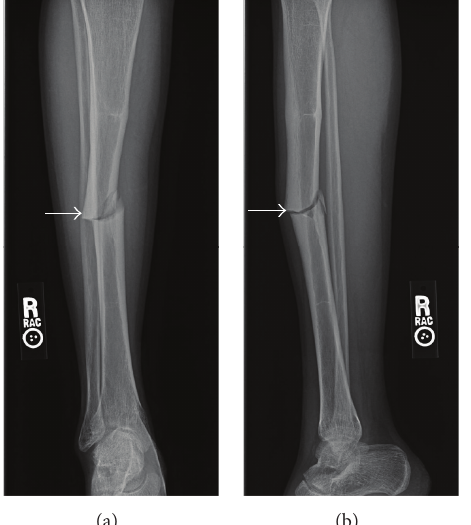
Figure 1: Young adult male with history of Rothmund-Thomson syndrome diagnosed at 2 years of age. Findings: (a) mildly comminuted and mildly displaced fracture through the mid diaphysis of the right tibia. There is lateral cortical thickening at the level of the fracture (arrow). (b) Mildly displaced fracture through the mid tibia diaphysis with focal anterior cortical thickening at the level of the fracture (arrow). Technique: